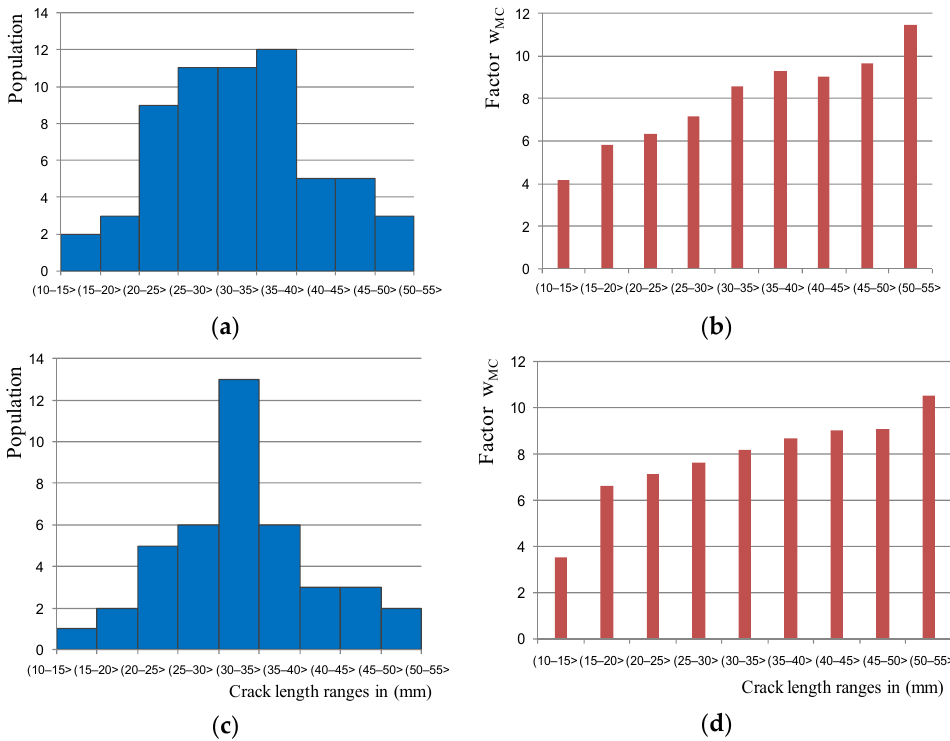
Figure 12. Results of surface crack depth measurements for selected brake discs: ( a ) crack number histogram for the first disc, ( b ) dependence of the w MC coefficient (crack length to its depth) for individual classes of crack length intervals of the first disc, ( c ) crack number histogram for the second disc, and ( d ) w MC relationship for the second target.